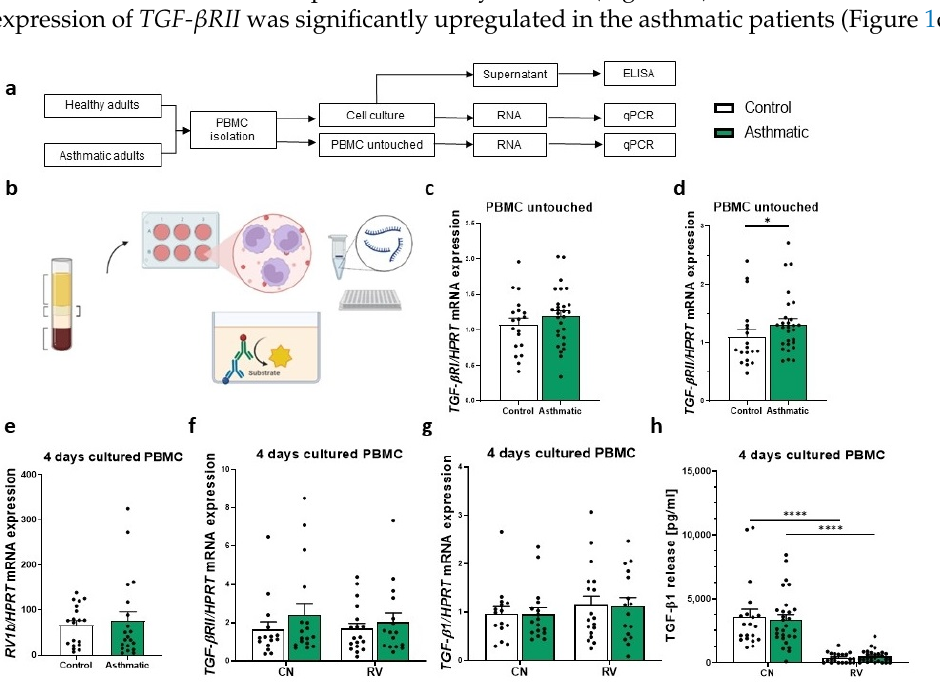
Figure 1. TGF- β response following rhinovirus infection in PBMCs. ( a ) Experimental design of the sample collection from healthy and asthmatic individuals. ( b ) Graphical abstract of the data collec-